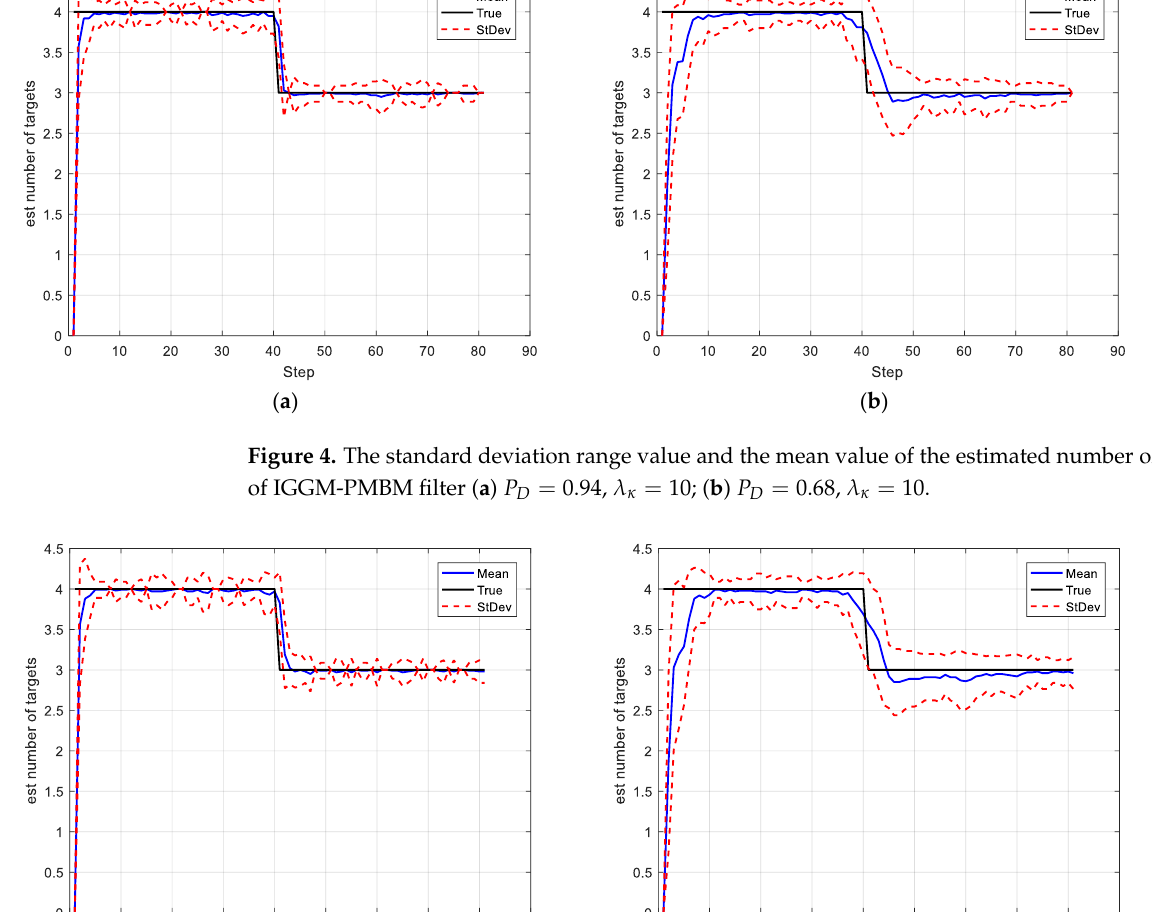
( b ) Figure 6. The average of estimated detection probability in 100 Monte Carlo runs. ( a ) 𝑃 𝐷 = 0.94 , 𝜆 𝜅 = 10 ; ( b ) 𝑃 𝐷 = 0.68 , 𝜆 𝜅 = 10 . ( a ) ( c ) Figure 7. Comparisons of ( a ) location error, ( b ) miss error and ( c ) false error with 𝑃 𝐷 = 0.68 , 𝜆 𝜅 = 10 .